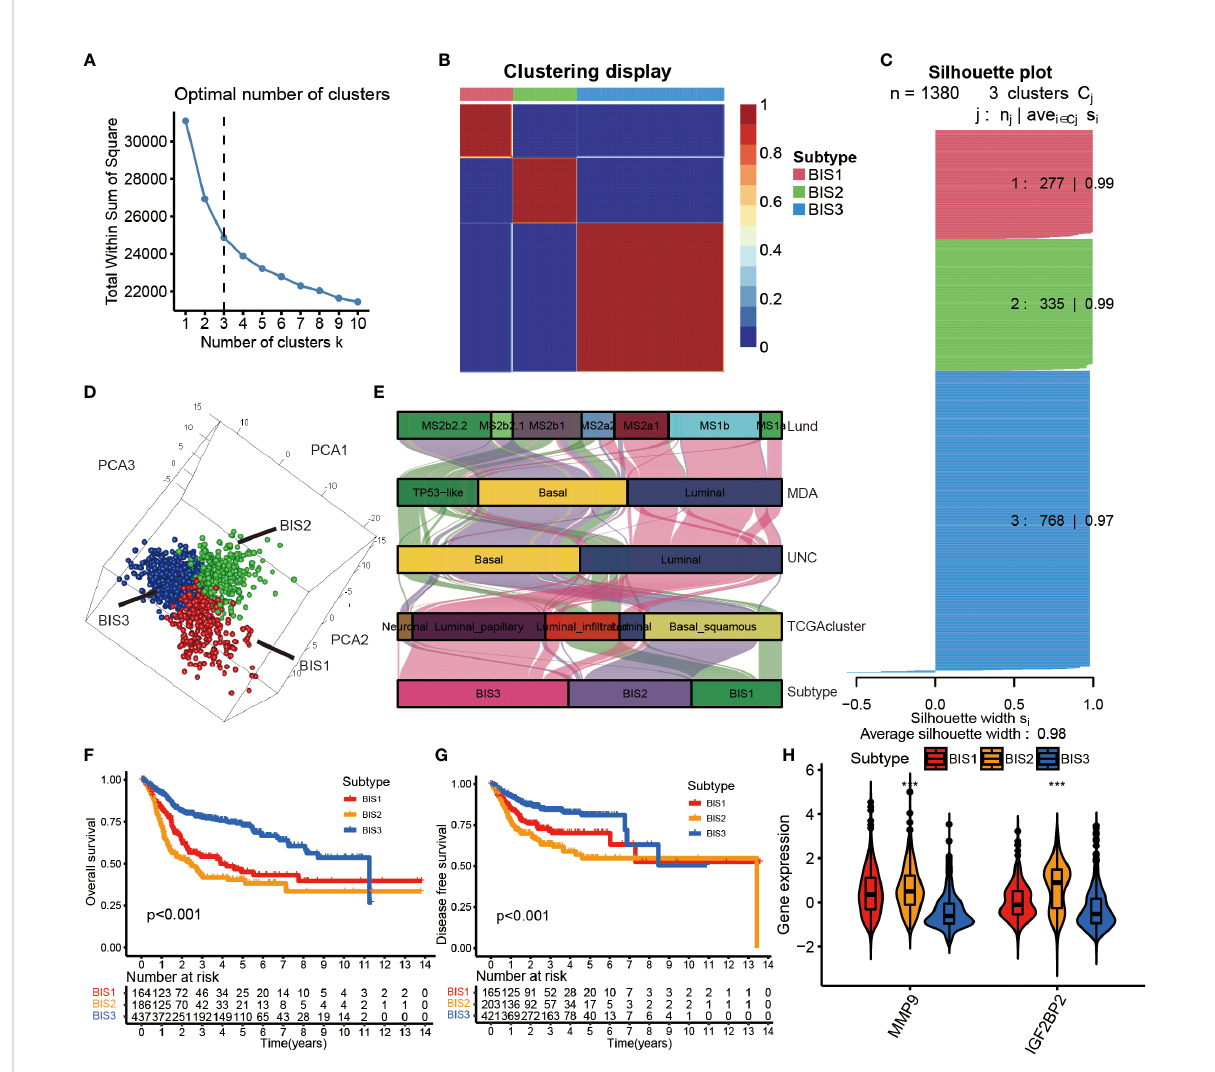
FIGURE 4 Identi fi cation of immune subtypes in BLCA. (A) The Total Whin Sum of Square of NMF analysis with varying cluster number (k=1-10). (B) Heatmap representing the consensus matrix in the Meta cohorts. (C) The Silhouette index of each sample after BLCA samples were divided into three clusters by NMF analysis. (D) Strati fi cation into three subtypes validated by 3D PCA analysis in the Meta cohorts. (E) Correlation between immune subtypes and other molecular subtypes con fi rmed by previous studies in the TCGA cohort. (F) Survival analysis of OS for three subtypes in the Meta cohorts. (G) Survival analysis of DFS for three subtypes in the Meta cohorts. The log-rank test was used to determine the statistical signi fi cance of the differences, and P< 0.05 was considered signi fi cant. (H) IGF2BP2 and MMP9 gene expression levels in three subtypes. ***P <